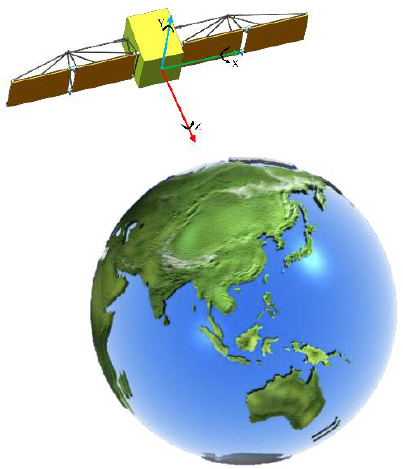
Figure 2. Service status of an Earth-observation satellite.